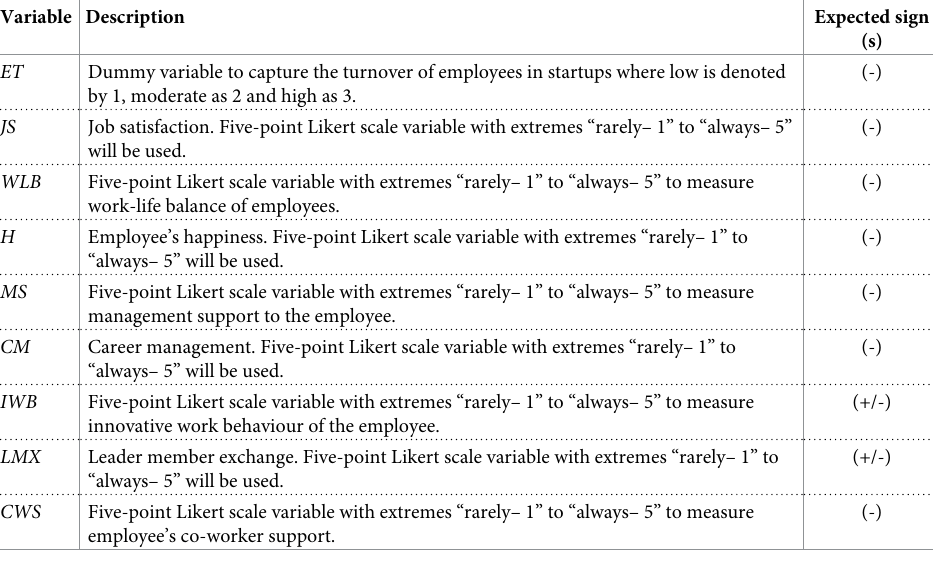
Table 2 indicates the variables explained in previous literature and definitions of the previ-